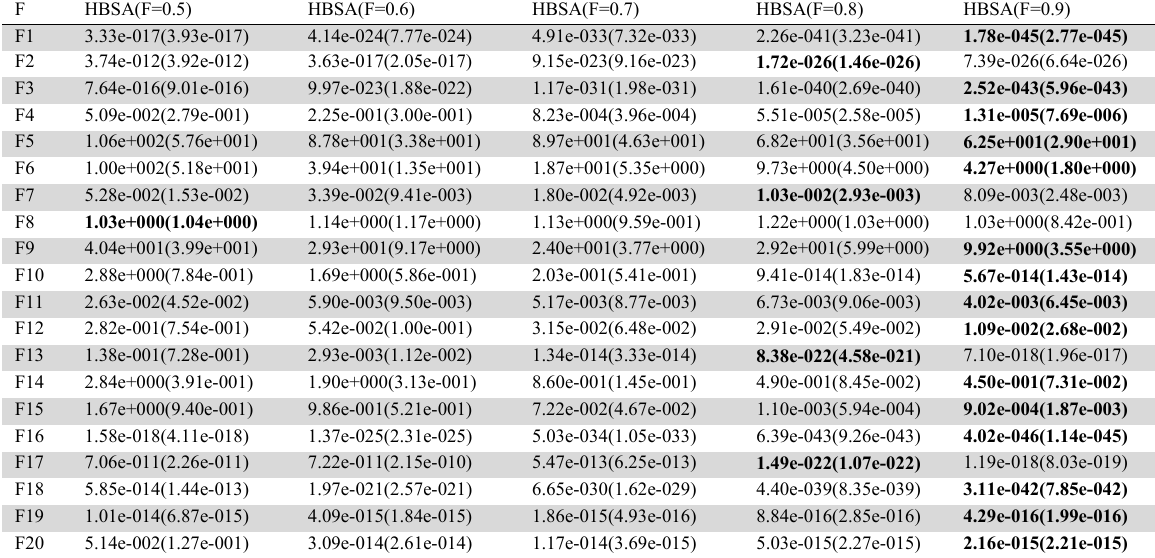
Comparison of statistical result of HBSA of error function value for different value of control parameter(F)